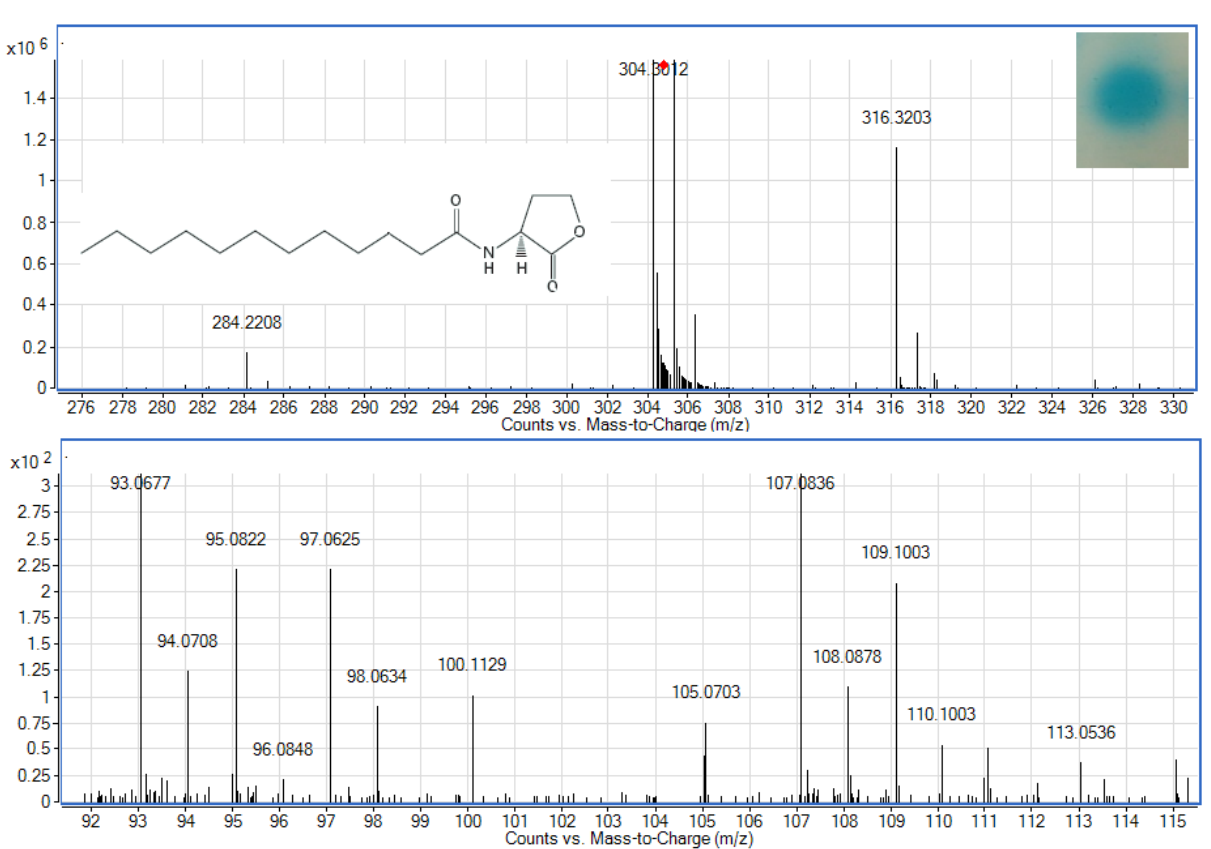
Figure 2. Detection of AHLs by A . tumefaciens NTL4(pZLR4) and mass spectrometry analysis of spent supernatants extracts of Enterobacter sp. (T1-1). Inset (top right) shows the AHL production of oral bacterial isolate Enterobacter sp. (T1-1) as detected by spotting the AHLs extract onto the biosensor lawn. Blue pigmentation showed that Enterobacter sp. isolate T1-1 produced long chain AHLs. Graph shows the mass spectra of parental ion of C12-HSL ( m/z 284.2208, upper panel) and product ions of C12-HSL in MS-MS analysis ( m/z 95.0822, 109.1003, lower